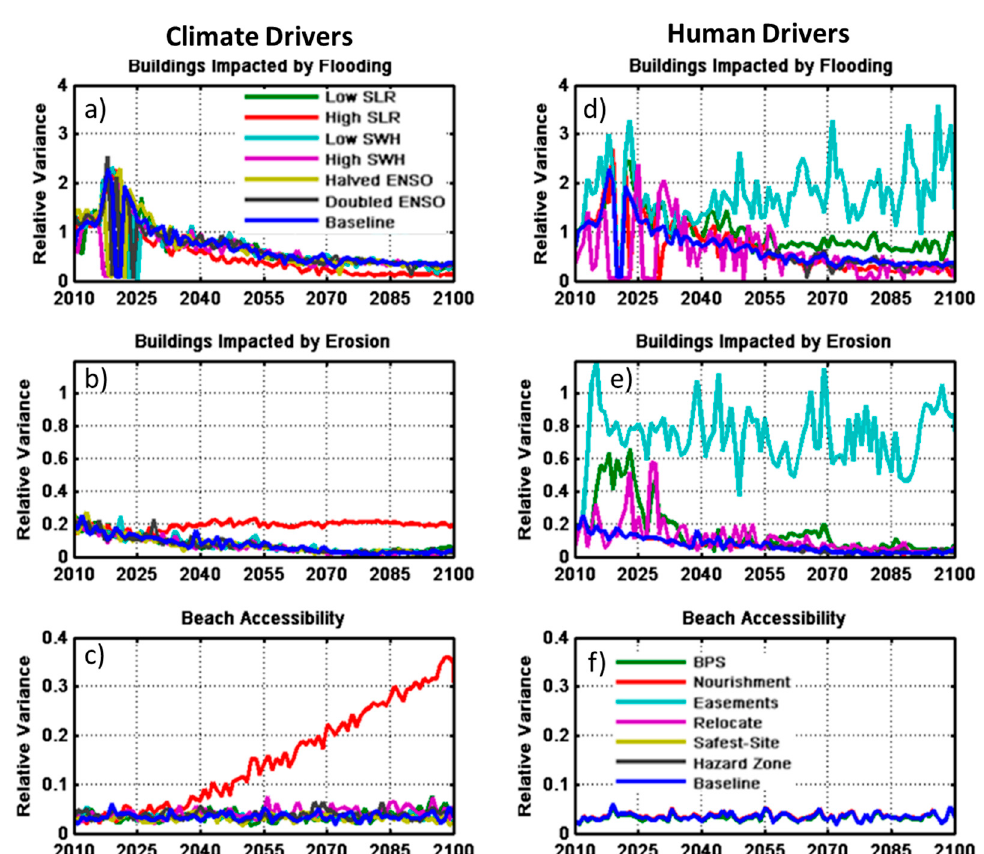
Figure 12. Relative coefficient of variance for each of the climate (left, a – c ) and policy (right, d – f ) drivers through time.